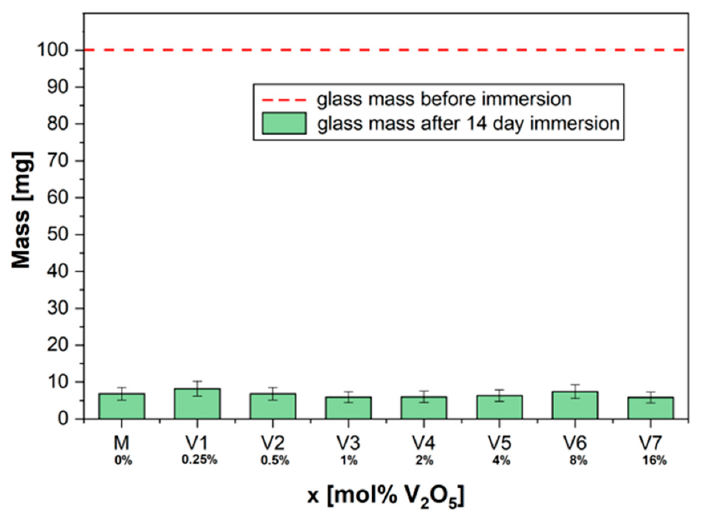
Figure 1. The solubility of glass powders: dry mass before and after immersion for 14 days in 10 mL deionized water.